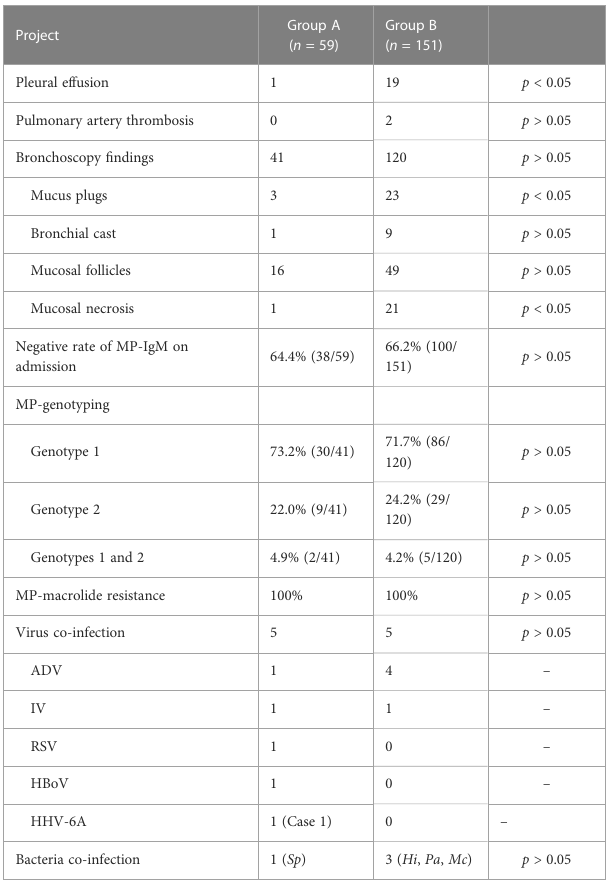
TABLE 4 The results of chest imaging, bronchoscopy, and pathogen test in MPP patients.